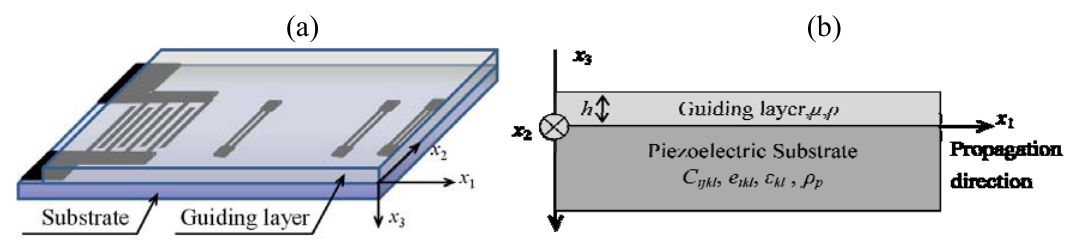
Figure 2. (a) The schematic of the Love wave reflective delay line. (b) The system coordinates of the theoretical